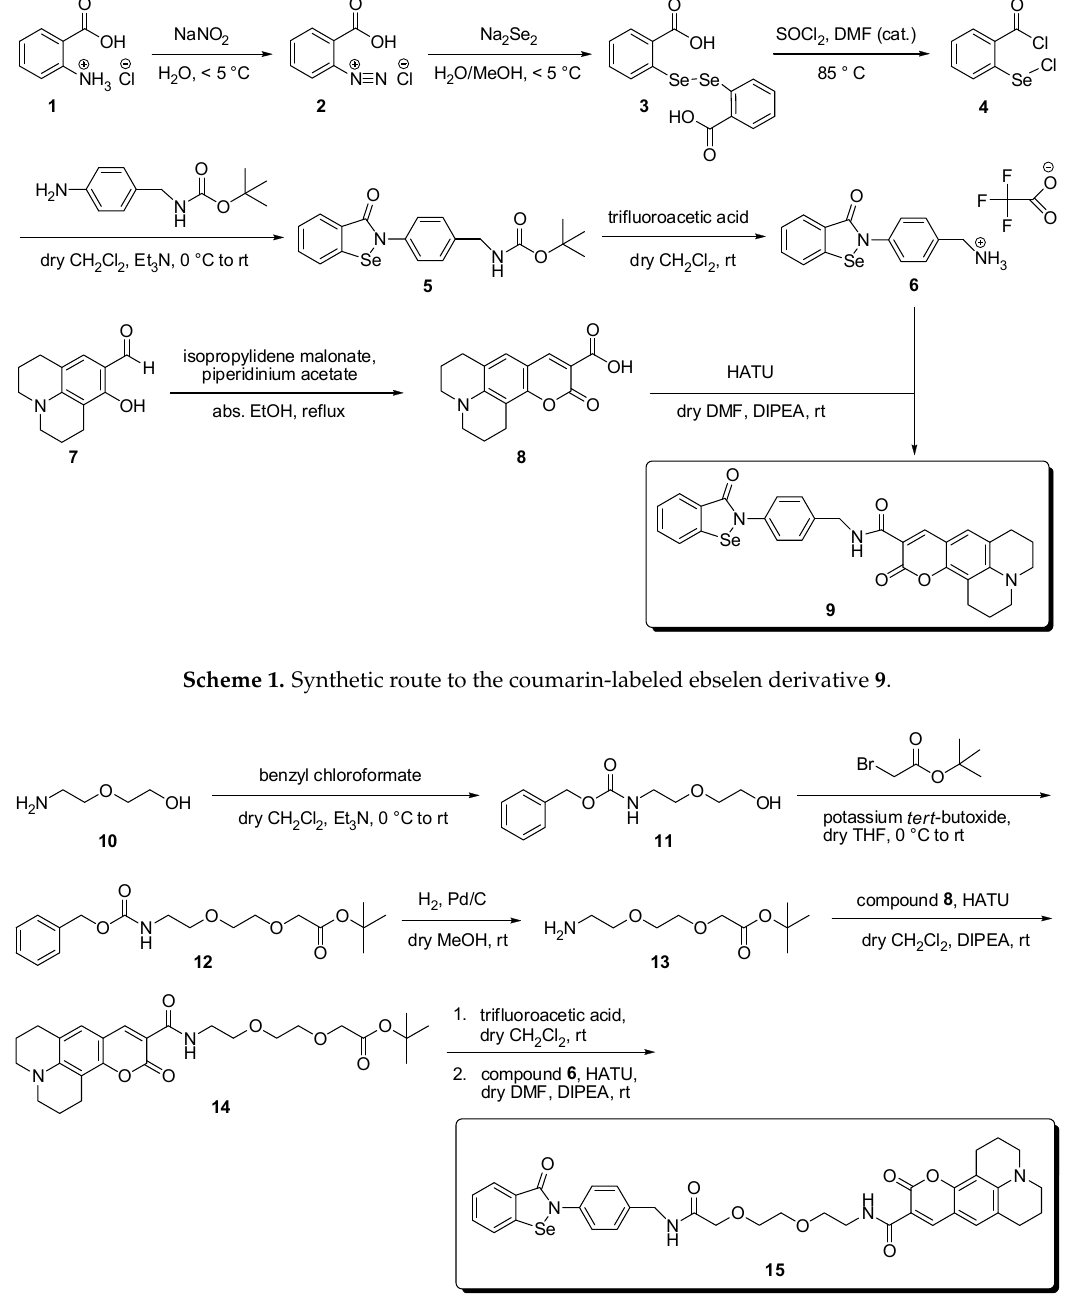
Scheme 2. Synthetic route to the coumarin-labeled ebselen derivative 15 .